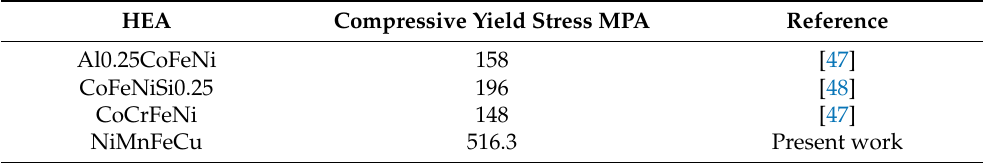
Table 6. Compressive yield stress of 3d transition metal based HEAs reported in the literature.